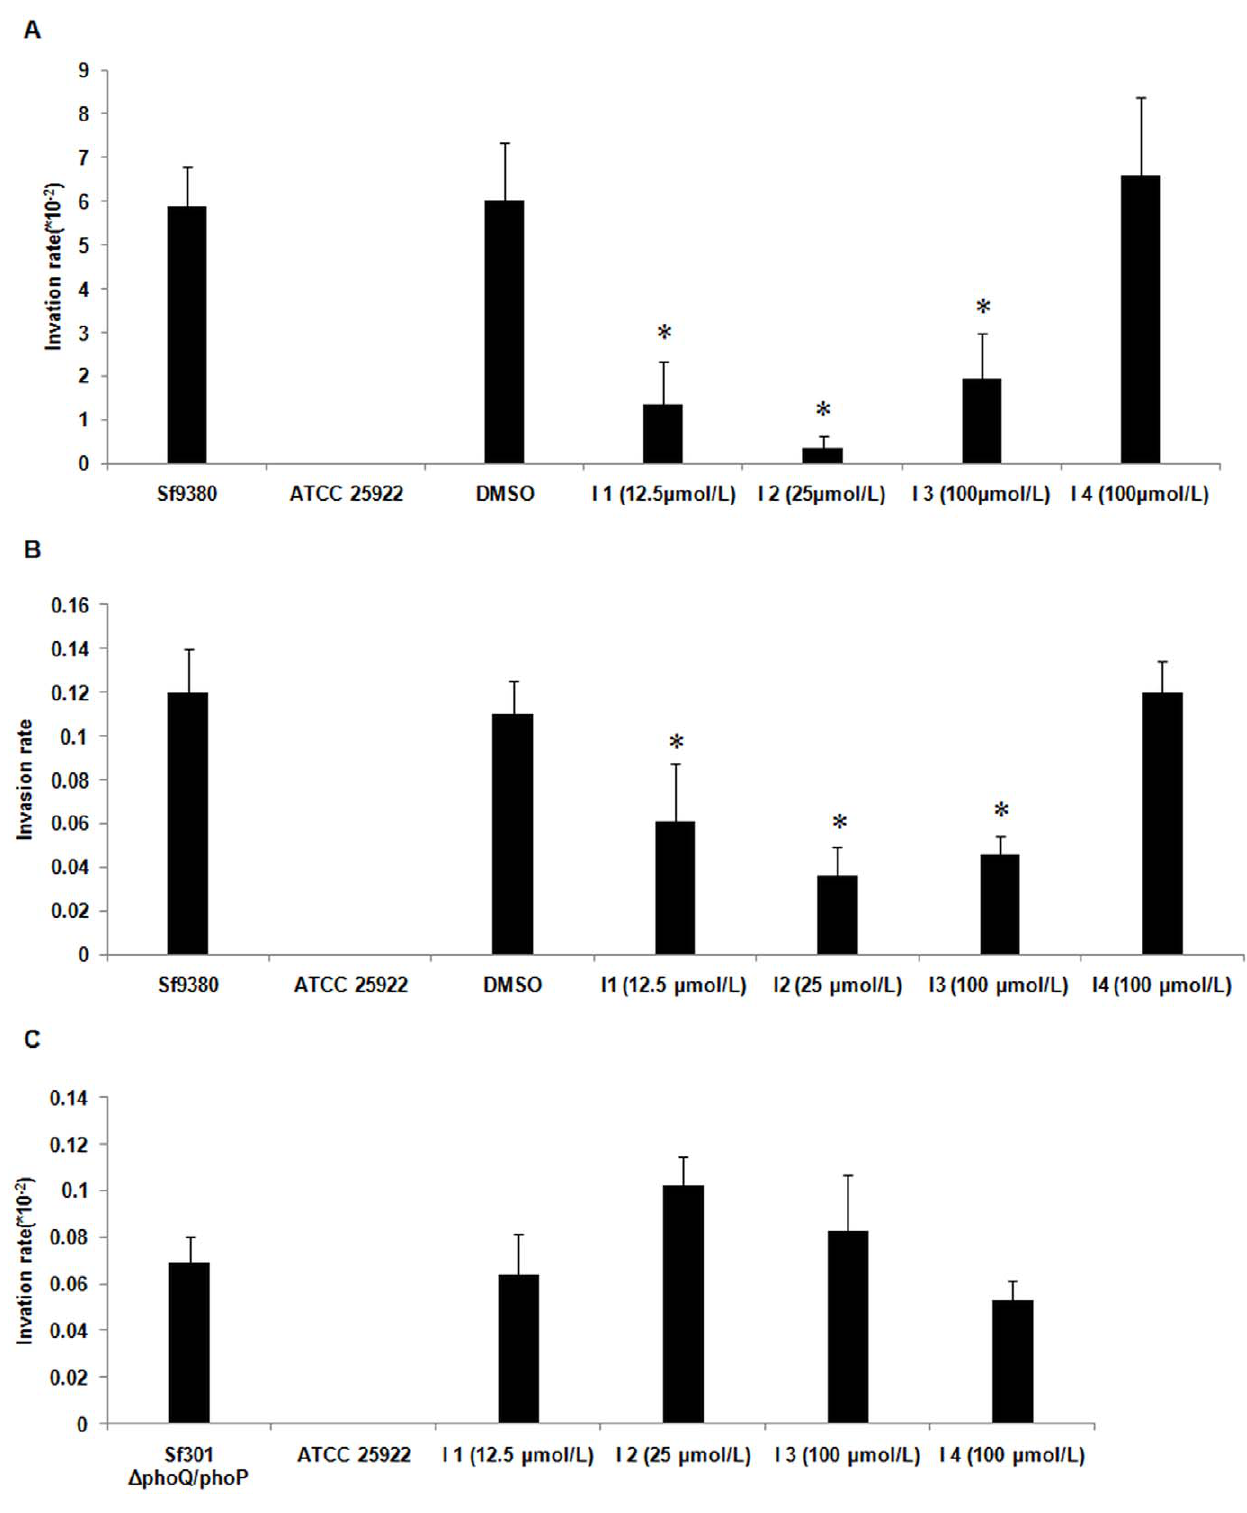
Figure 6. The effects of potential PhoQ inhibitors on virulence of Shigella . The gentamicin protection assay shows the inhibitory effect of the four potential PhoQ inhibitors on S. flexneri HeLa cells invasion. The bacteria pre-treated with potential PhoQ inhibitor were added to HeLa cells at a multiplicity of infection of 100. Then gentamicin was added to kill extracellular bacteria and cell lysates were plated onto LB plates, and the colonies were counted. The results of the assays were expressed as the number of bacteria recovered from gentamicin-treated cells divided by the number of inoculated bacteria added to the cell. S. flexneri Sf 9380 (treated without DMSO), a clinical strain with strong virulence, served as the positive control for the cell invasion assay; E. coli ATCC 25922 (treated without DMSO), an avirulent strain, served as the negative control for the cell invasion assay; bacteria treated with 0.1% DMSO (the solvent of the potential PhoQ inhibitor) also served as a control for the cell invasion assay. Values are means 6 standard deviations from 6 independent wells. *p , 0.01 vs. Sf 9380. ( A ) The effects of potential PhoQ inhibitors on cell invasion of S. flexneri Sf 9380 PLoS ONE | www.plosone.org